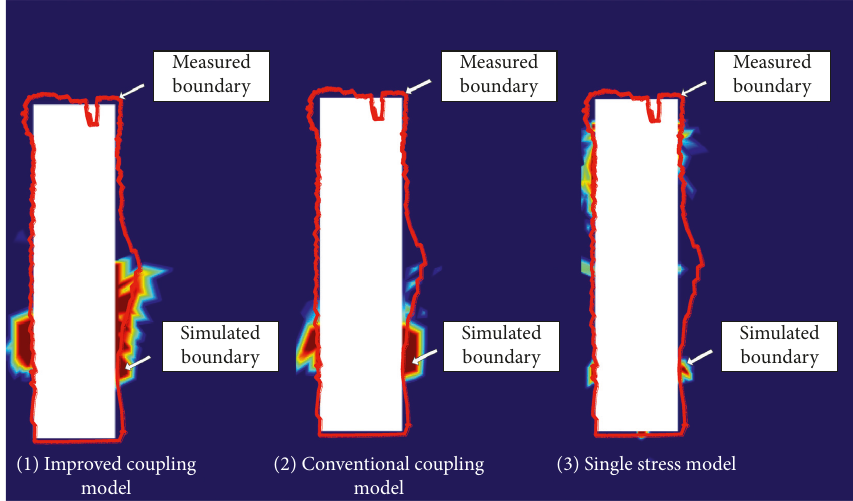
Figure 11: Comparison of numerical failure characteristics with measured